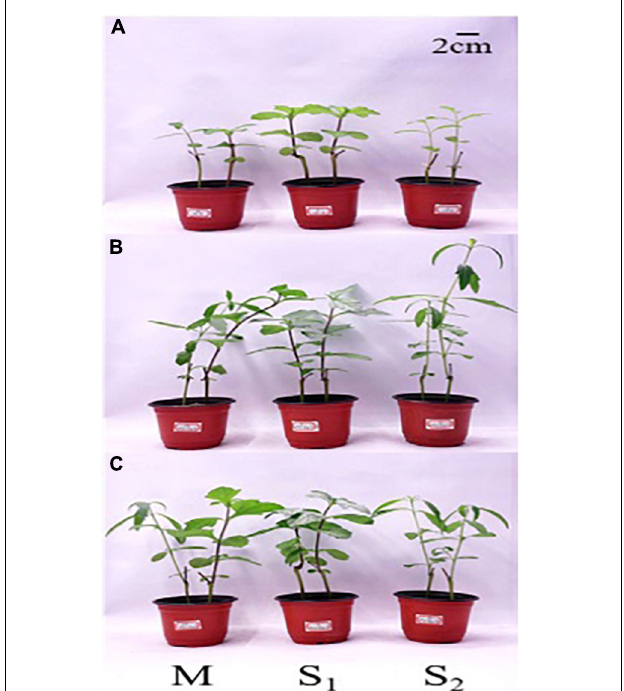
FIGURE 2 | Effect of different nitrogen (N) forms and competitive treatments on plant growth under high N conditions. M, interspecific competition between W. trilobata and W. chinensis ; AA, ammonium nitrogen; NN, nitrate nitrogen; S 1 , intraspecific competition of W. trilobata ; S 2 , intraspecific competition of W. chinensis ; (A) no nitrogen addition; (B) nitrogen form ratio AN:NN, 2:1 with total nitrogen amount of 15 g N · m − 2 · year − 1 ; (C) nitrogen form ratio AN:NN, 1:2 with total nitrogen amount of 15 g N · m − 2 · year − 1